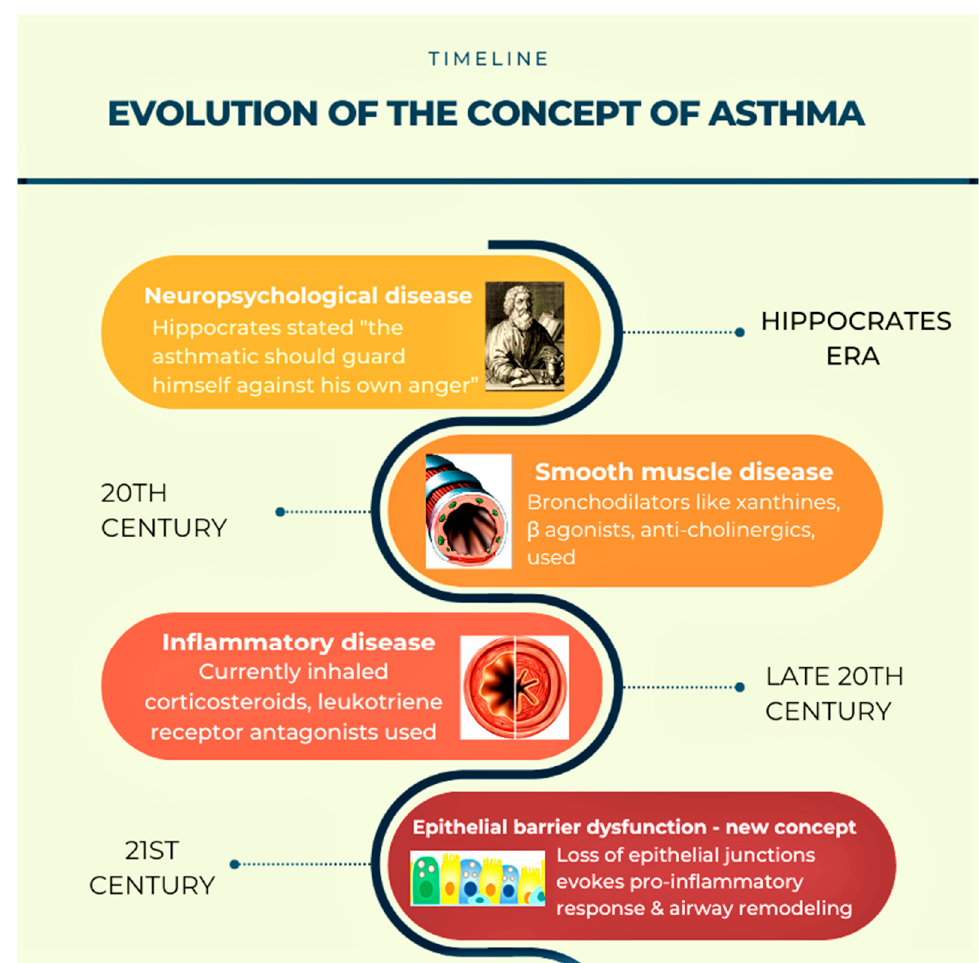
Figure 1. A diagram that describes the concept changes that happened in asthma pathogenesis with time. with